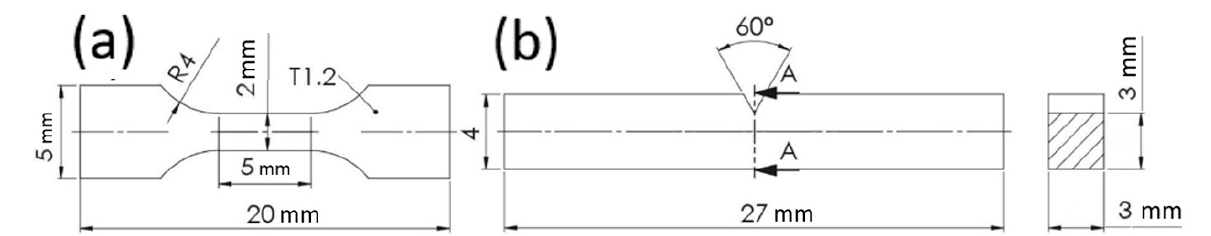
Figure 1. Samples for mechanical testing, ( a ) tensile test, ( b ) Charpy impact test.